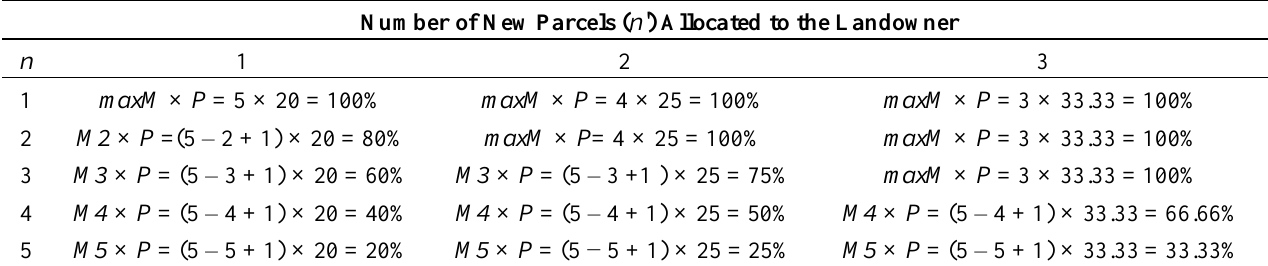
Table 1. An example for the calculation of the partial satisfaction rate. Number of New Parcels ( n ' ) Allocated to the